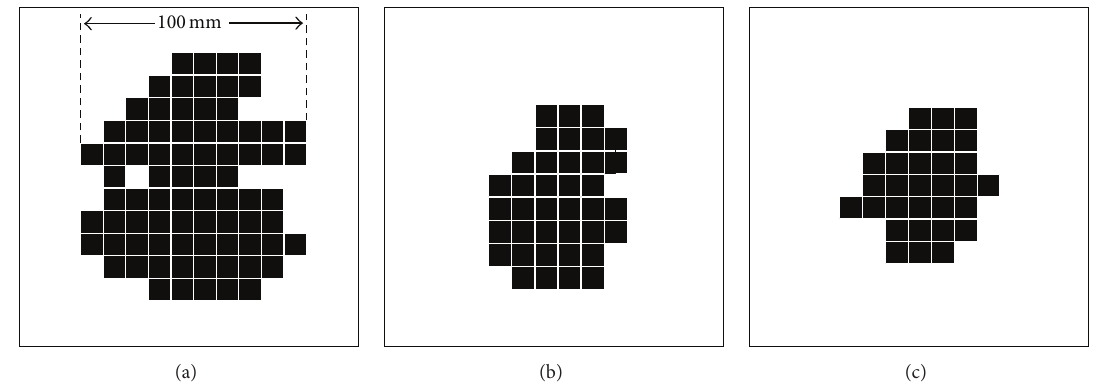
Figure 8: Measured read width at 𝑥𝑦 -plane. (a) 𝑧 = 10 mm, (b) 𝑧 = 20 mm, and (c) 𝑧 = 40 mm.